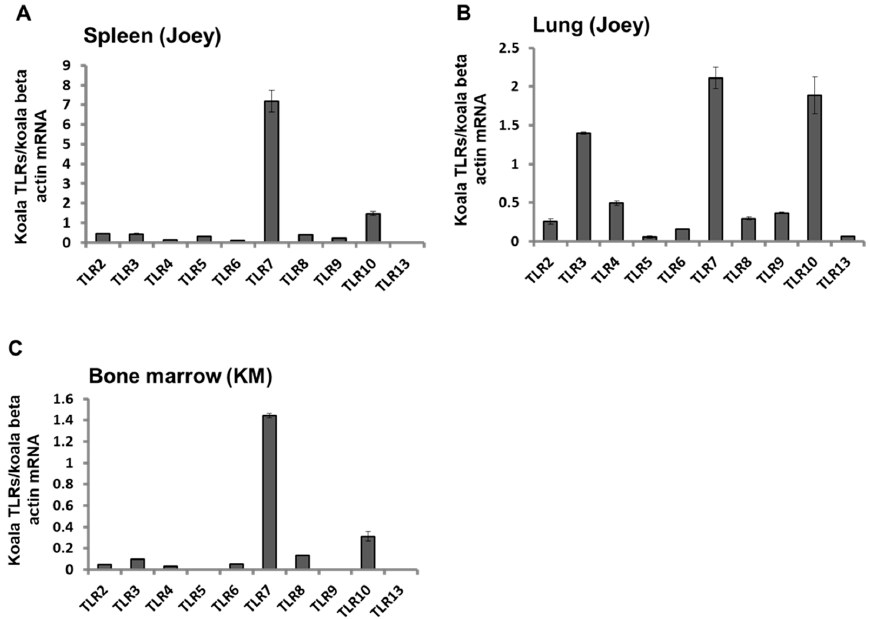
Figure 3. Expression profile of TLR mRNAs in koala tissues. Expression patterns of TLR2–TLR10, and TLR13 mRNAs in the spleen ( A ), and lung ( B ) of a dead joey, and bone marrow of KM ( C ) are shown. The transcript levels were normalized against koala beta actin mRNA. Data are presented as mean ± SD ( n = 2).